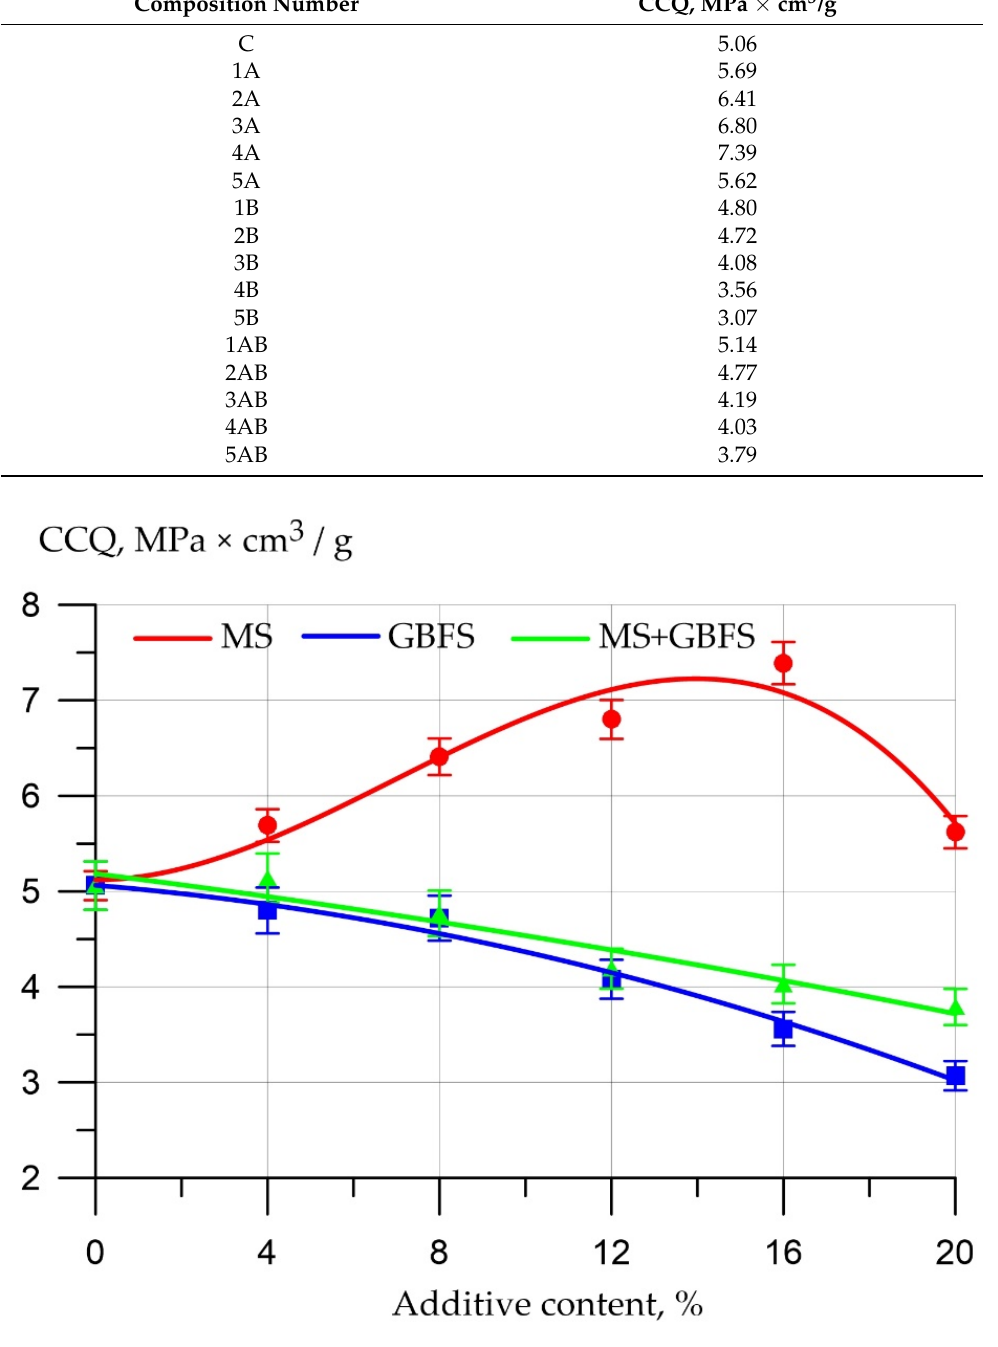
Figure 7. Change in the coefficient of structural quality of non-autoclaved aerated concrete depending on the percentage of binder replacement by various types of additives.